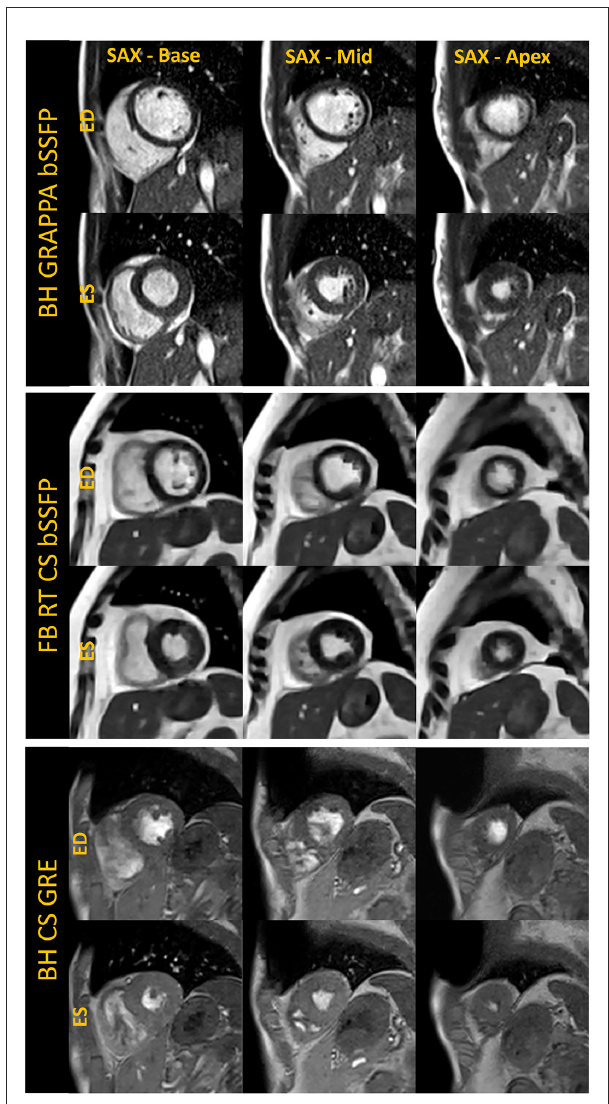
FIGURE3 Basal, mid, and apical short-axis cine images are shown in the end-diastole (ED) and end-systole (ES) cardiac frames for breath-held segmented GRAPPA bSSFP, free-breathing real-time CS bSSFP and breath-held segmented CS GRE method. The images shown for each technique were acquired in separate volunteers.